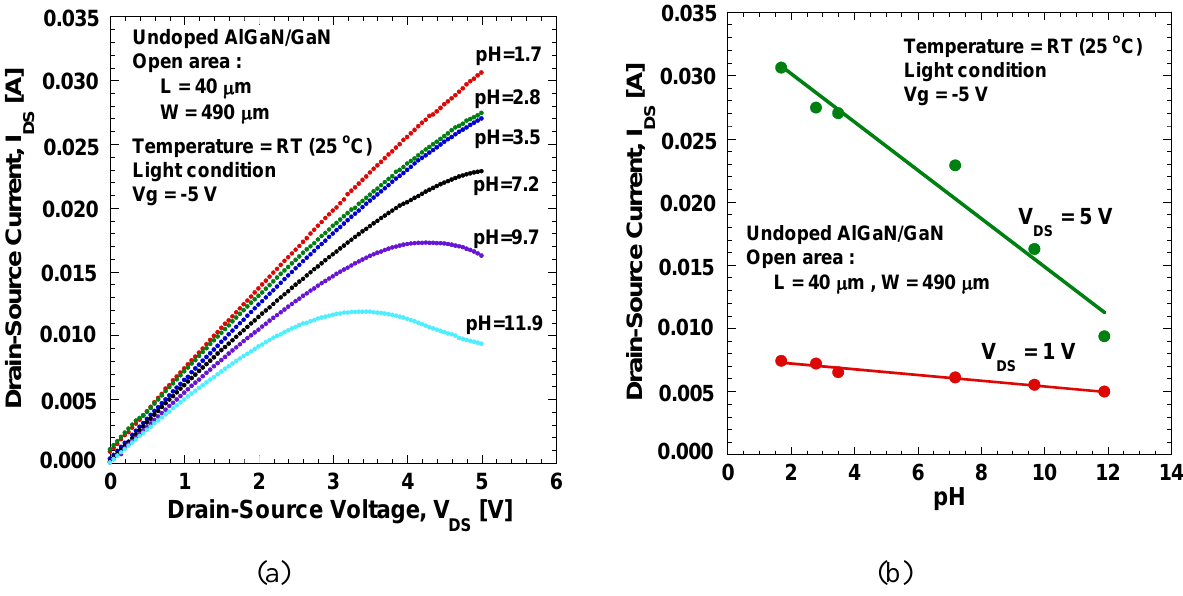
Figure 6. (a) I -V characteristics as a function of pH values and (b) measured I DS DS